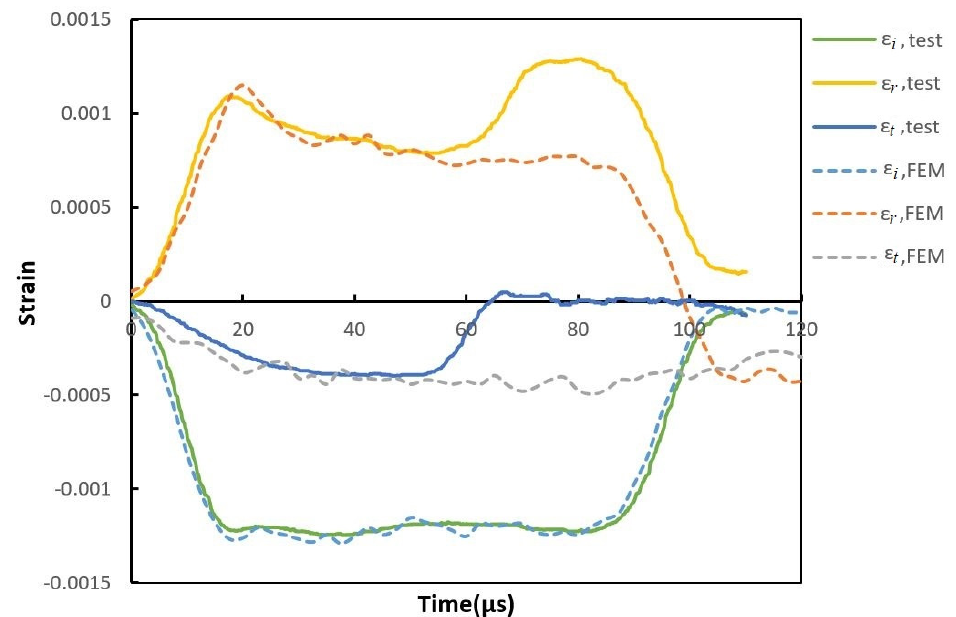
Figure 16. Comparison of strain signals in the incident and transmitted bars between the experiment and the simulation.